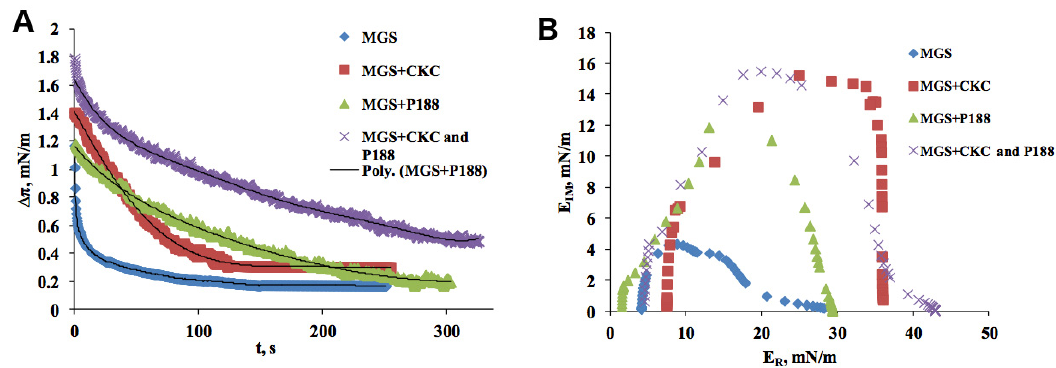
Figure 2. Rheological properties of MGS under the influence of CKC and poloxamer 188 (P188). Relaxation transient (points) and Maxwell rheological equations (lines) of the MGS layer over pure saline solution subphase (physiological saline solution buffer (PBS) pH 7.4), MGS layer over subphase containing 3.6 × 10 − 7 M CKC, MGS over 10 − 6 M P188, and MGS in the presence of 10 − 6 M P188 + 3.6 × 10 − 7 M CKC ( A ); Cole–Cole plot for viscoelastic parameters of the investigated films of MGS, MGS layer over subphase containing 3.6 × 10 − 7 M CKC, MGS over 10 − 6 M P188, and MGS in the presence of 10 − 6 M P188 + 3.6 × 10 − 7 M CKC ( B ).